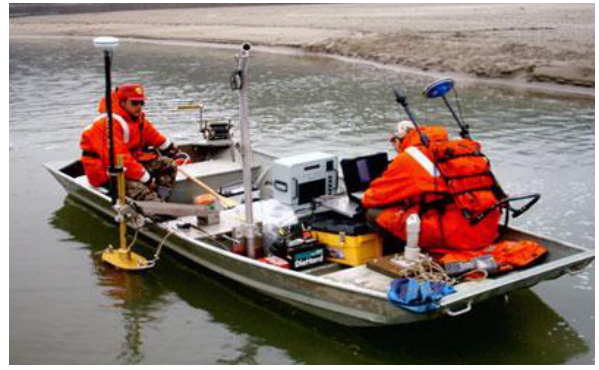
Figure. 3. Normal bathymetry surveying boat with surveyors on-board (USGS,